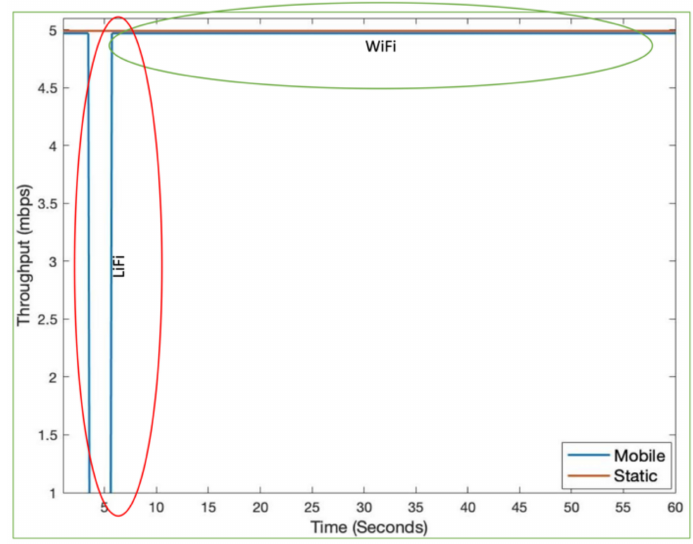
Figure 7. Instantaneous throughput for hybrid